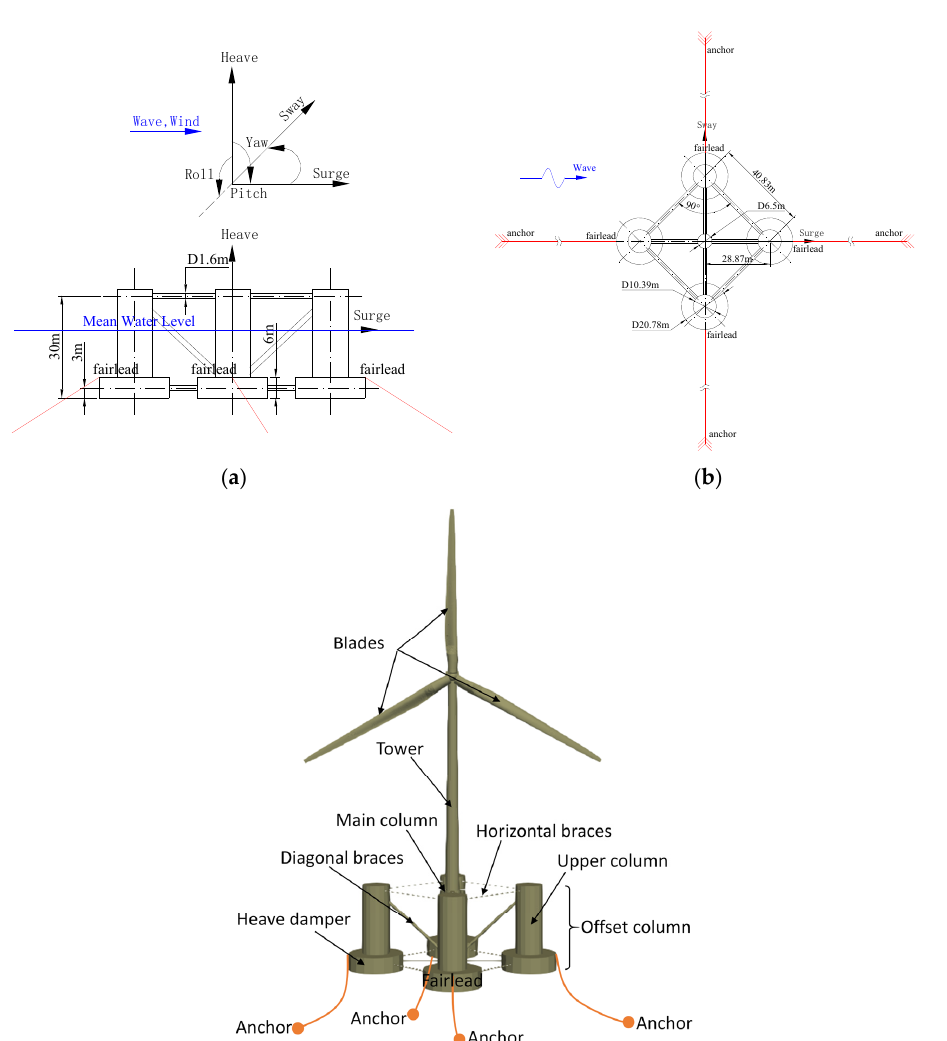
Figure 3. Sketch of the semi-submersible floating system with four offset columns (Model 1), ( a ) side view, ( b ) bird view, and ( c ) isometric view of the semi-submersible floating platform. The six DFO are defined as surge, sway, heave, roll, pitch, and yaw. For all simulations presented, the direction of wave propagation is aligned with the platform, which is in the surge direction.